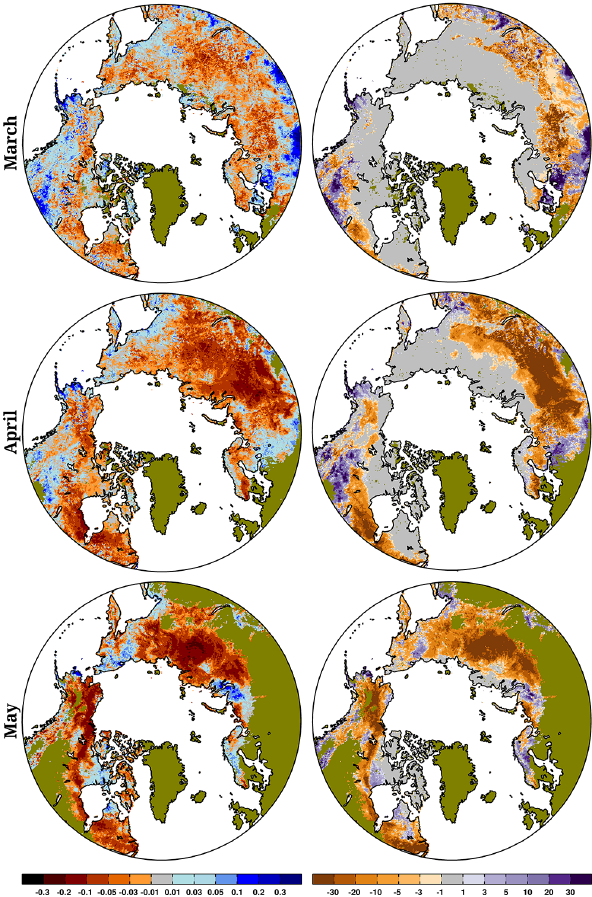
Figure 2. Average albedo (left panel) and SCF (right panel) changes during the years 2000–2012, determined as described in the text. Snow-free area, Greenland and Iceland are shown in green and are not considered in this